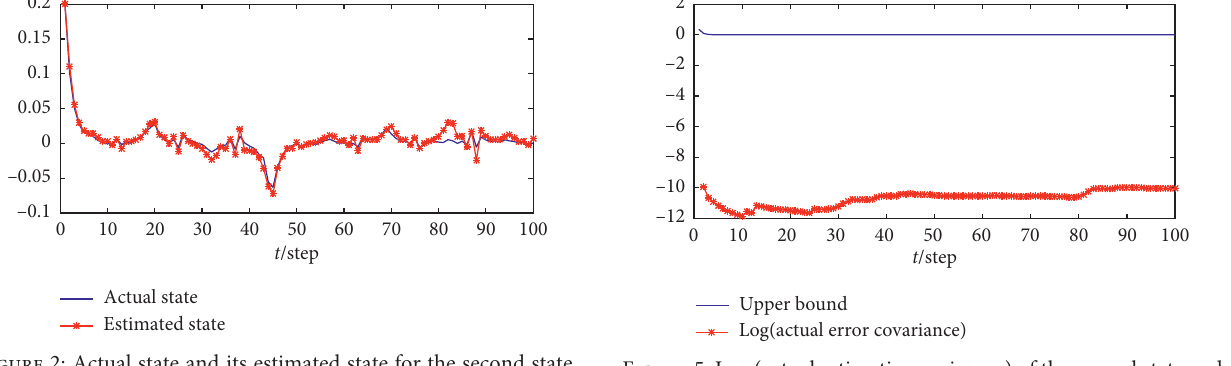
Figure 5: Log (actual estimation variances) of the second state and its upper bound.